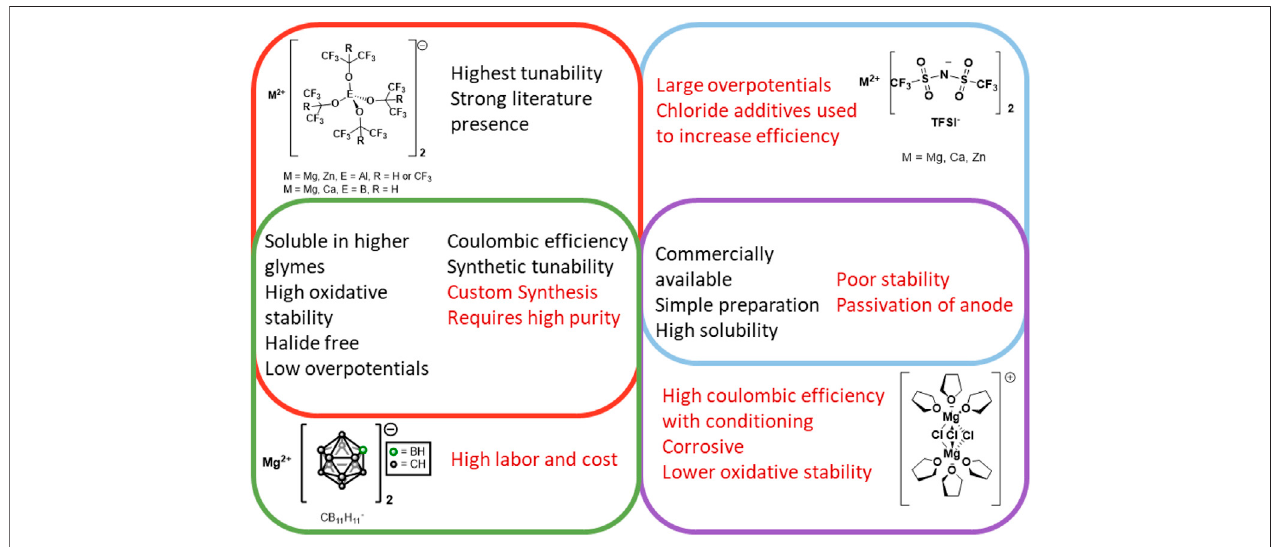
FIGURE 1 | An overview of four select types of MV electrolytes and the unique and shared pros (in black) and cons (in red) associated with them.